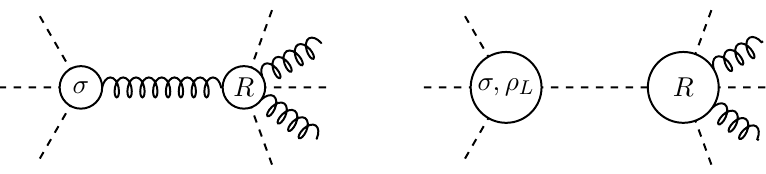
Figure 3 . Two special massless factorization channels of our integrand. The dashed lines represent scalars and the curly lines represent gluons. Note that there are no original external gluons on the